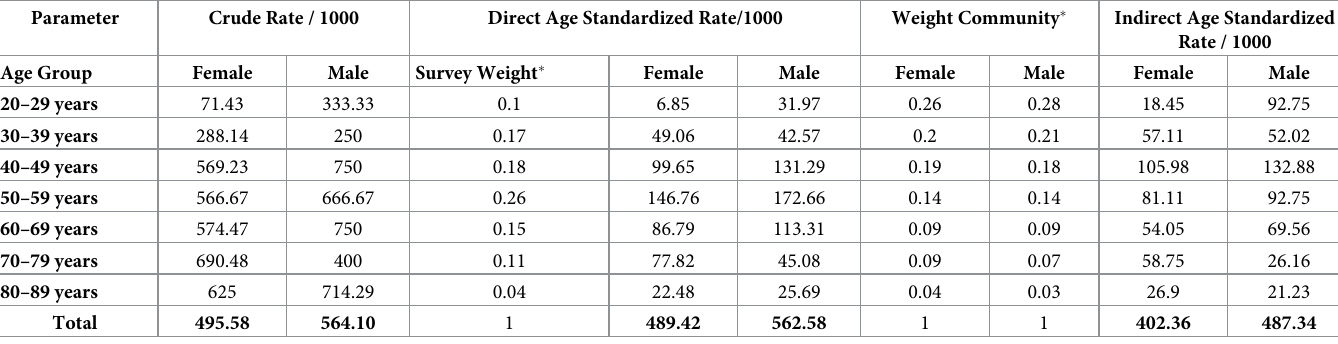
Table 4. Crude and age standardized prevalence rate of hypertension among dwellers of the Nyive community.